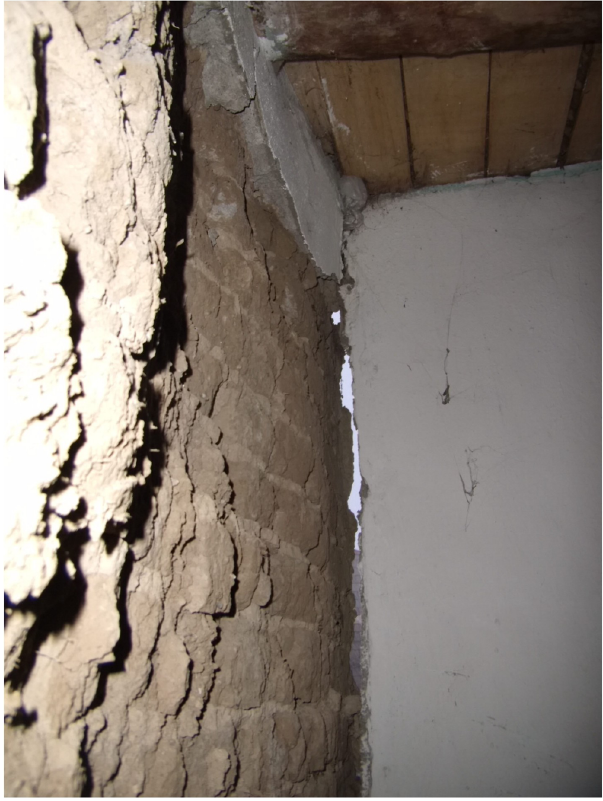
Fig. 20. The interior plaster spalling and severe separation that oc- curred in the intersection of the walls in an adobe